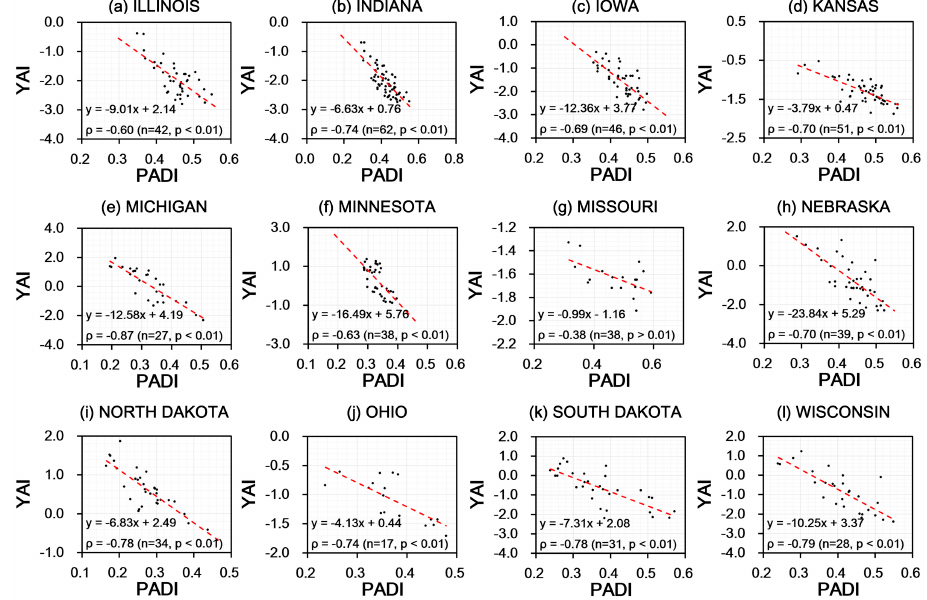
Figure 8. Scattering plot between YAI and the final PADI value in September, 2012 in twelve states of Midwest, including ( a ) Illinois, ( b ) Indiana, ( c ) Iowa, ( d ) Kansas, ( e ) Michigan, ( f ) Minnesota, ( g ) Missouri, ( h ) Nebraska, ( i ) North Dakota, ( j ) Ohio, ( k ) South Dakota, and ( l ) Wisconsin. Linear regression line and Spearman’s rank correlation value were given as well.